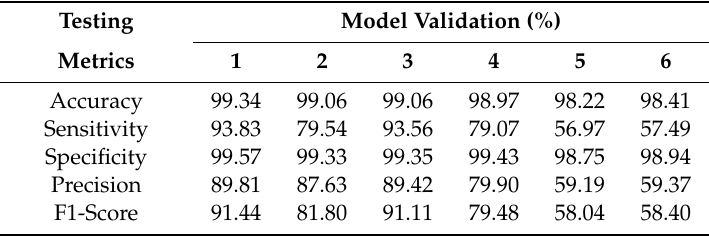
Table 4. The performance evaluation of DL models in the testing phase.